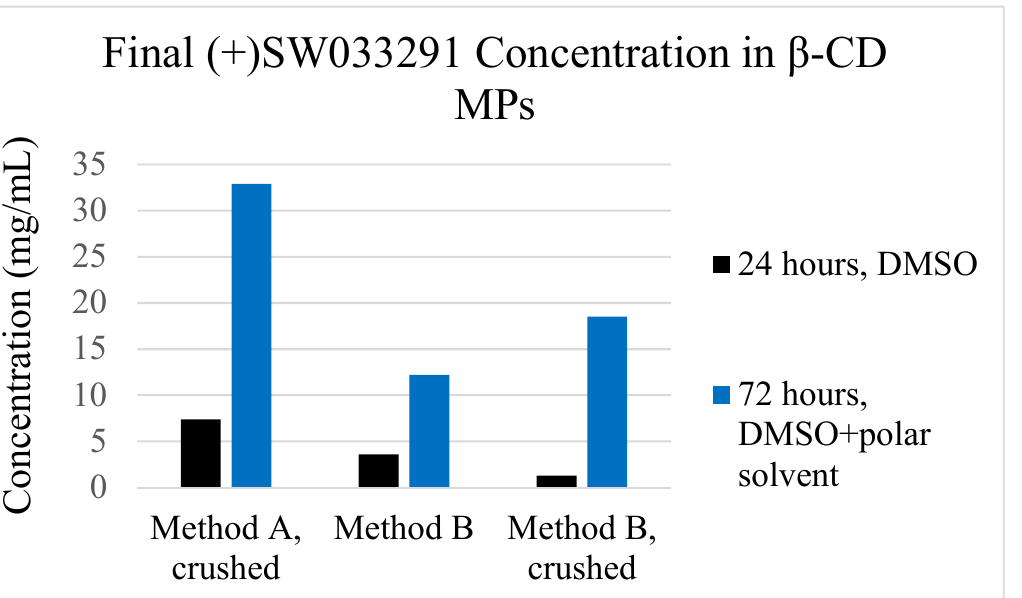
Figure 5. Final loading concentrations for β-CD MP formulations utilizing a ‘24-hour’ loading protocol and our investi- gated ‘72-hour’ loading protocol, which uses loading solution of both DMSO and a polar solvent (water) to help drive complexation (referred to as “DMSO + polar solvent”).